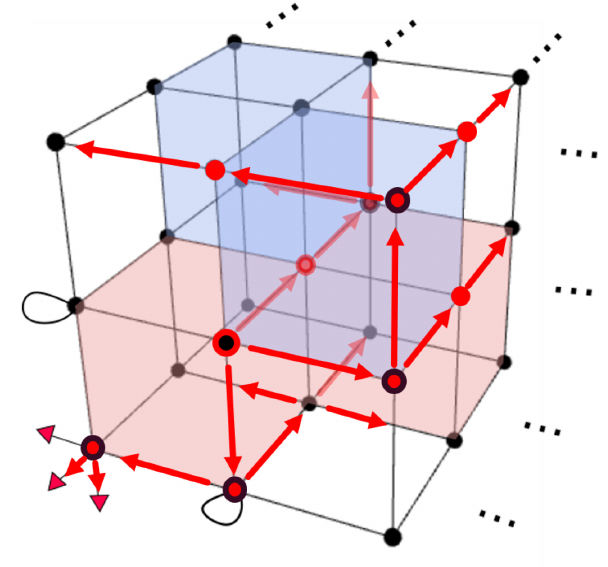
FIG. 13. A treelike operator resulting from pushing logical operators in the tensor network. Red denotes the pushing of Pauli Z s. We neglect some of the dangling legs for tensors on the boundary of the cube because that depends on how we choose the boundary condition. For example, the three dangling legs’ bottom-left corner are contracted with Z -type stopper tensors and two on the nearby edges are contracted among themselves. Red arrow marks the path of operator